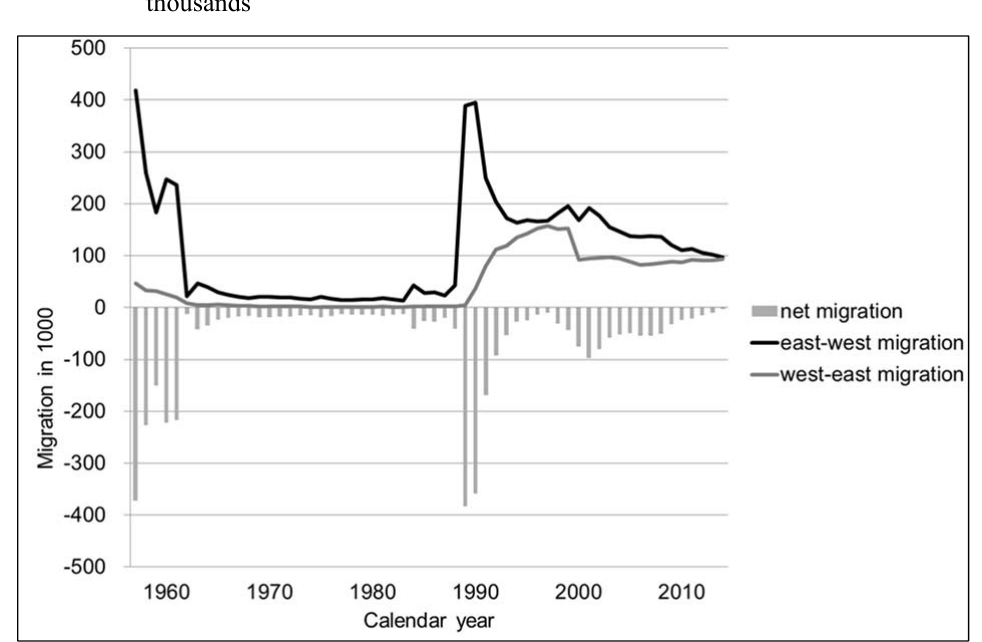
Figure 2 : Migration between East and West Germany, calendar years 1957-2014, in